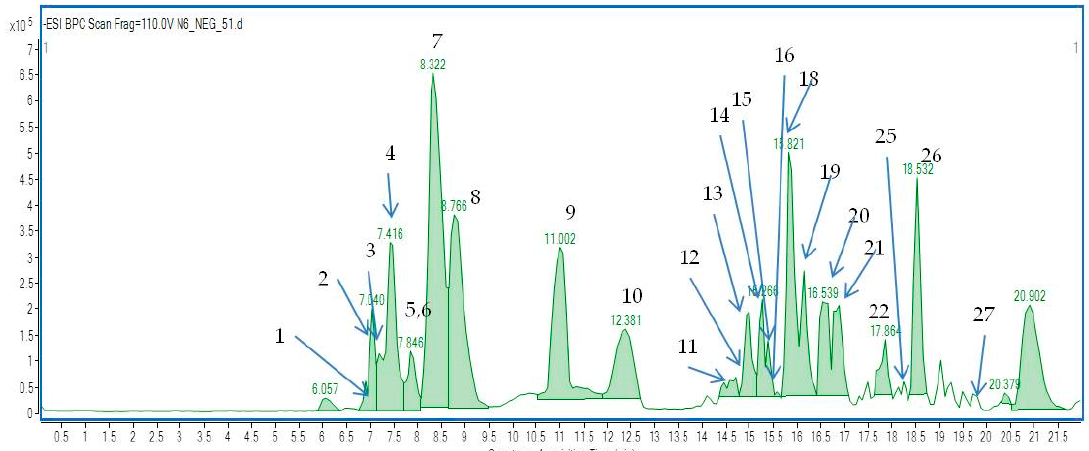
Figure 3. The TIC chromatogram recorded in the negative ionization modes for the Achillea biebersteinii E6